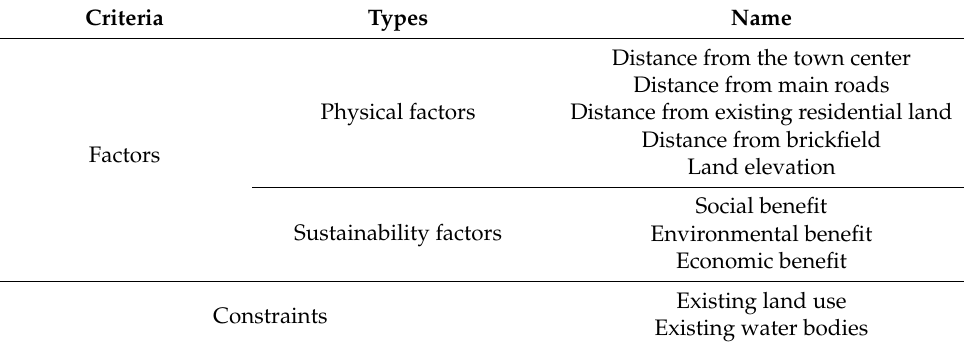
Table 1. List of factors and constraints used for residential land suitability. Criteria Types